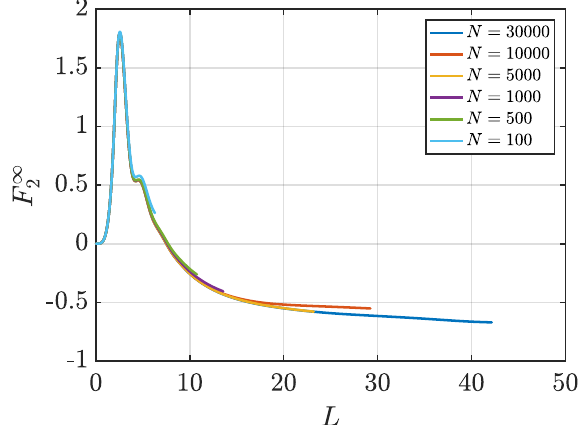
Figure 12. Estimation of the surface term in the thermodynamic limit F ∞ LJ fluid at T = 2 and ρ = 0.4 (dimensionless units). The values of F ∞ varying number of molecules N . The used RDFs are provided in Figure